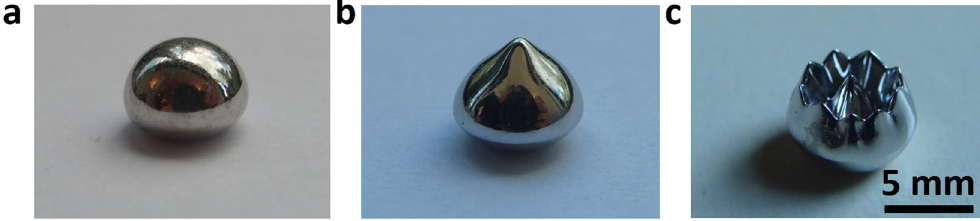
Figure 7. Instability pattern morphology formed by undercooled liquid Co under different magnetic fields, ( a ) wihtout magnetic field, ( b ) 1 T magnetic field and a field gradient 15 T/m and ( c ) 4 T magnetic field and a field gradient 60